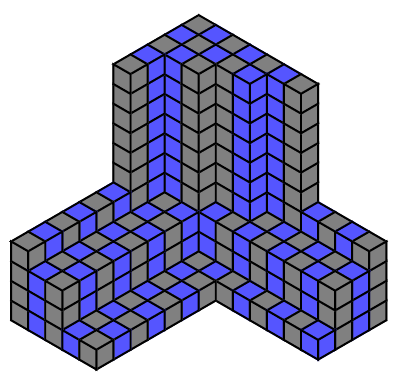
Figure 10 . The subcrystal for the open BPS states in ( C 2 / Z n ) × C geometry, with asymptotics Y 1 = { 4 , 3 , 3 , 1 , 1 } , Y 2 = { 4 , 3 , 3 , 1 } , Y 3 = { 7 , 5 , 3 , 1 , 1 }